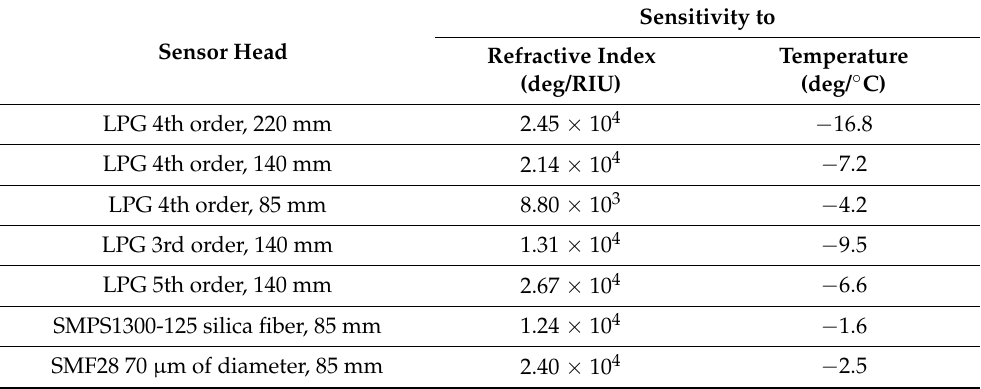
Table 1. Resume of the results obtained with the Michelson modal